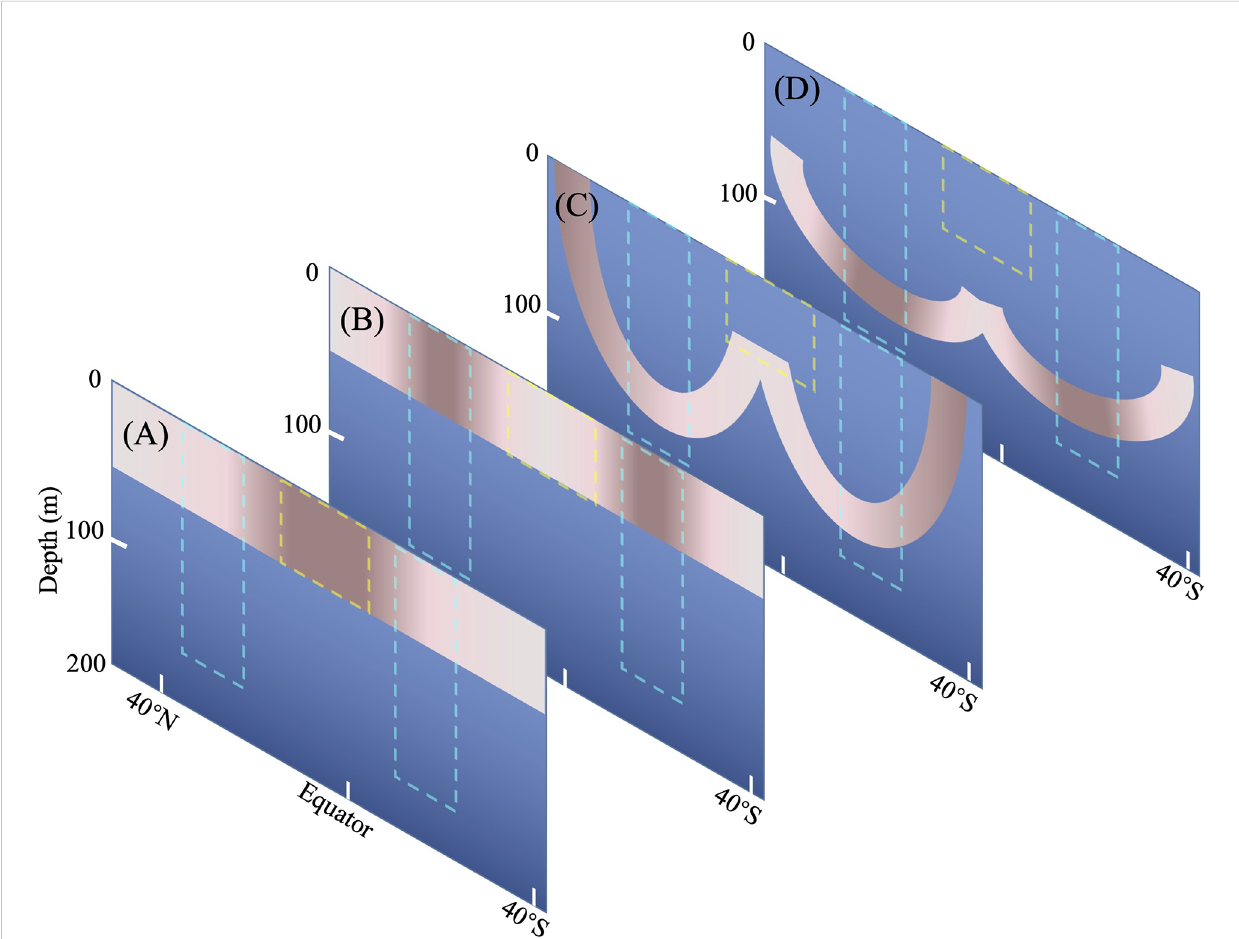
FIGURE 11 Conceptual model of Tintinnina communities composed of four sub-communities. (A) Equatorial sub-community, (B) Gyre sub-community, (C) Frontal sub-community, (D) Deep Chl a Maximum sub-community. The yellow box indicates the Equatorial Zone centre. The cyan boxes delimit gyre centres. Coral and rose color indicate the core and pioneer areas, respectively: the darker the color, the higher abundance and species